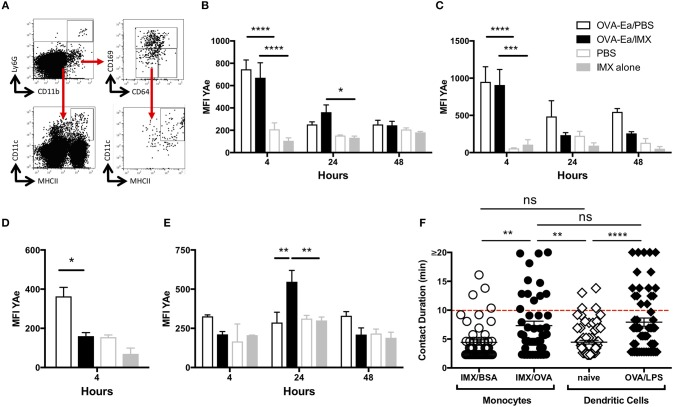
Recruited monocytes present antigen and may be observed interacting with T cells in the lymph node at 24 h post-immunization. (A) Representative plots showing flow cytometry gating strategy for the identification of CD11b+CD64+ monocytes, for CD11b+CD169+ SCS macrophages and CD11b- or CD11b+ CD11c+MHCII+ dendritic cells. Graphs showing mean (±SEM) YAe MFI on CD11b- (B) and CD11b+ (C) dendritic cells at 4, 24, and 48 h; mean (±SEM) YAe MFI SCS macrophages (D) at 4 h; mean (±SEM) YAe MFI on monocytes (E) at 4, 24, and 48 h. Groups contained 3 animals and data is representative of three independent experiments. (F) LysM-EGFP or CD11cYFP mice were immunized in the footpad (OVA or BSA/ISCOMATRIX or OVA/LPS respectively) ~20 h later the draining popliteal lymph node was surgically exposed. OTII DSRed T cells and monocytes (GFP+) or DCs (YFP+) were imaged by live real time multiphoton microscopy. Interaction between T cells and monocytes (and T cells and DCs was identified by colocalization of the DSRed signal with the GFP or YFP signals and tracked for up to 20 min, 48 such interactions were tracked in the OVA/ISCOMATRIX treated mice. IMX = ISCOMATRIX™ adjuvant, *P < 0.05, **P < 0.01, ***P < 0.001 ****P < 0.0001.